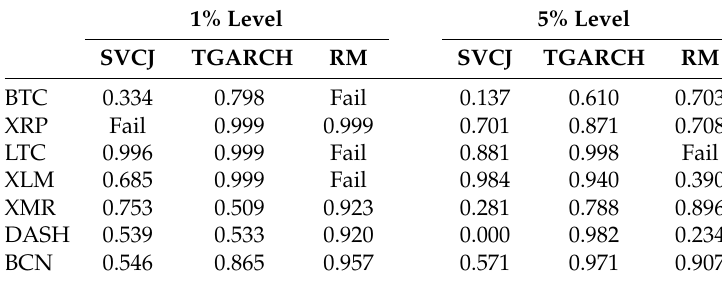
Table 5. Expected Shortfall backtesting